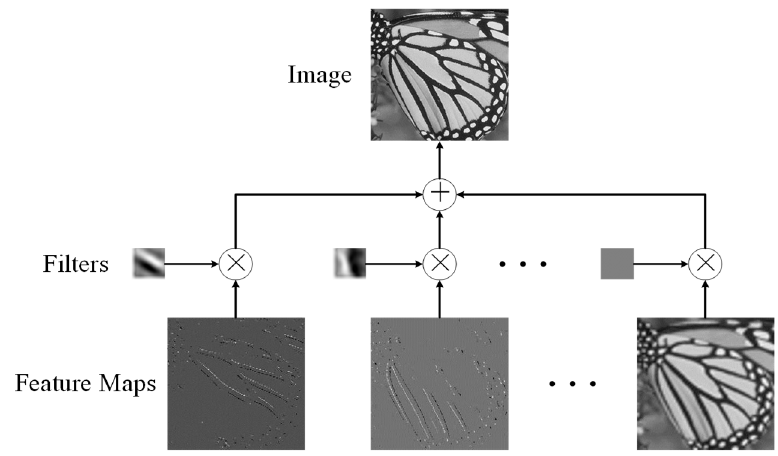
Figure 1. The framework of convolutional sparse coding (CSC).